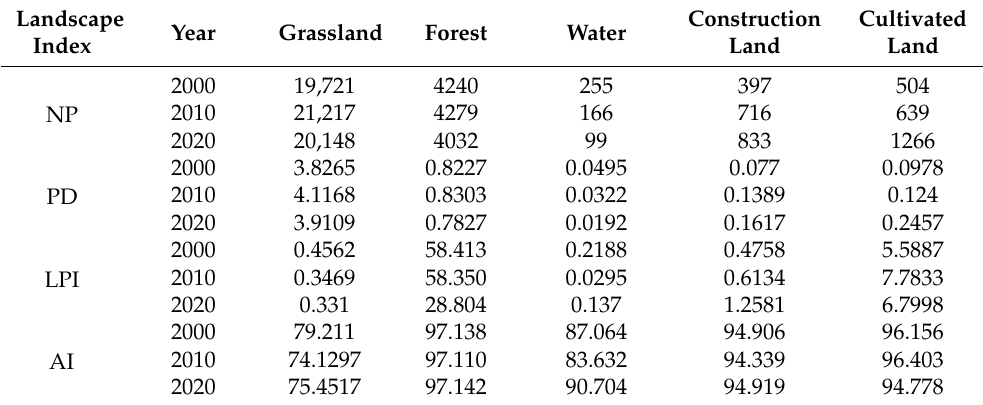
Table 7. Landscape class-level index change in the ECA of western Beijing from 2000 to 2000.